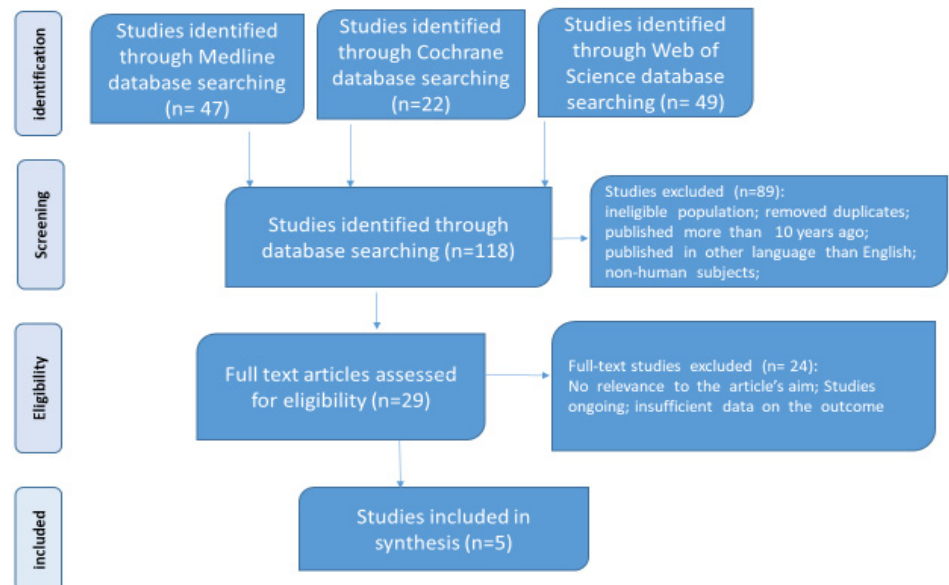
Figure 1. Flowchart for the study selection process according to PRISMA (Preferred Reporting Items for Systematic Reviews and Meta-Analyses) recommendations.